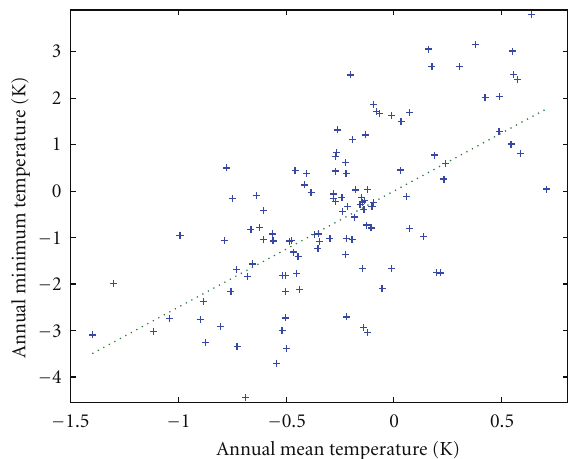
Figure 8: Coterminous USA mean annual minimum temperature anomalies plotted against annual mean temperature anomalies, relative to the 1976–2005, over years since 1900. The least-squares regression line shown has the equation y = (2 . 50 ± 0 . 49) x ( R 2 = 0 .